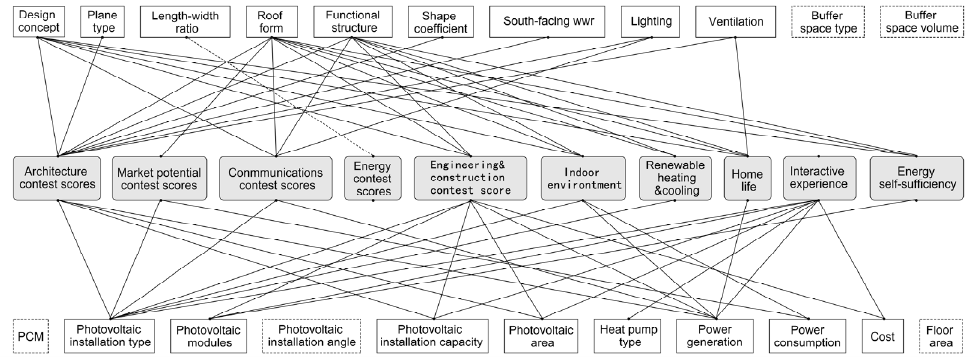
Figure 9. Correlation results analysis.